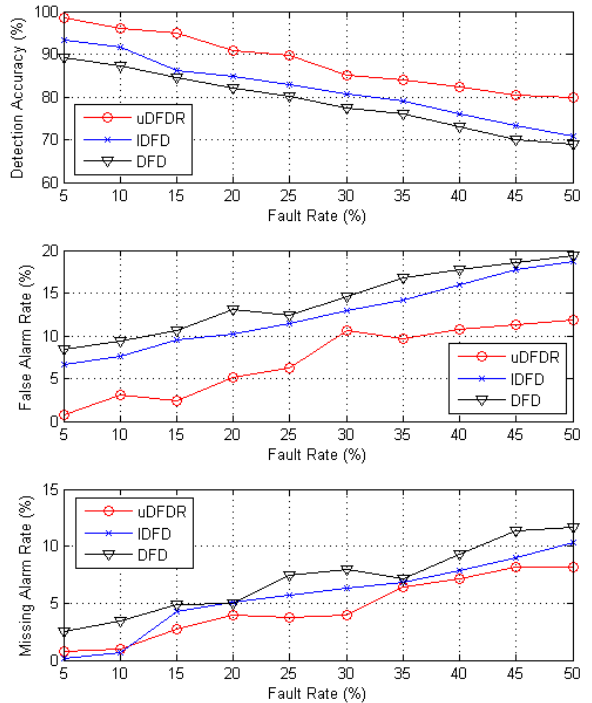
Figure 6. Detection effects under 40 working node